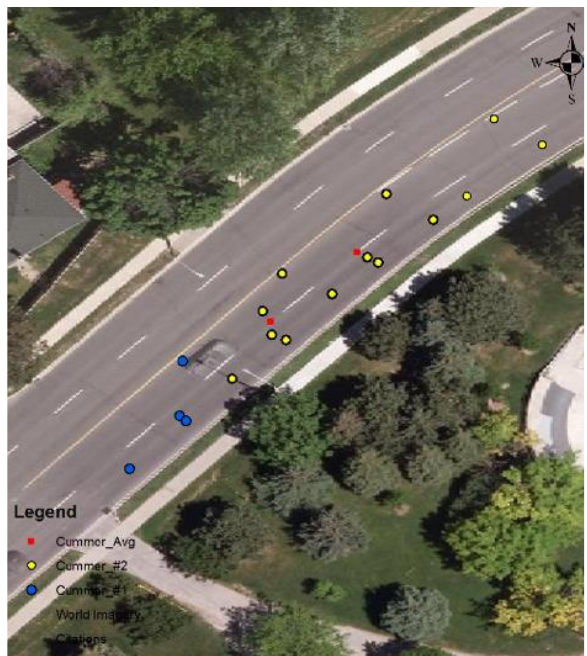
Figure 5 . Two clusters with their members Table 3 represents the integrated probability distribution